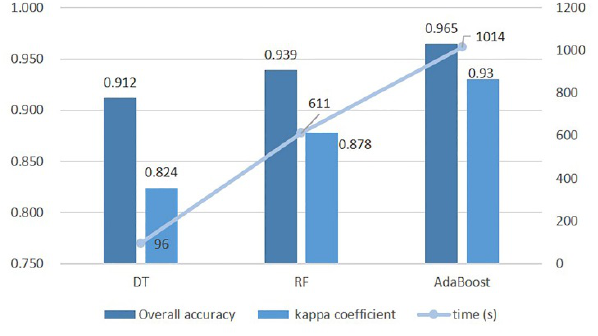
Figure 7. Classifier accuracy